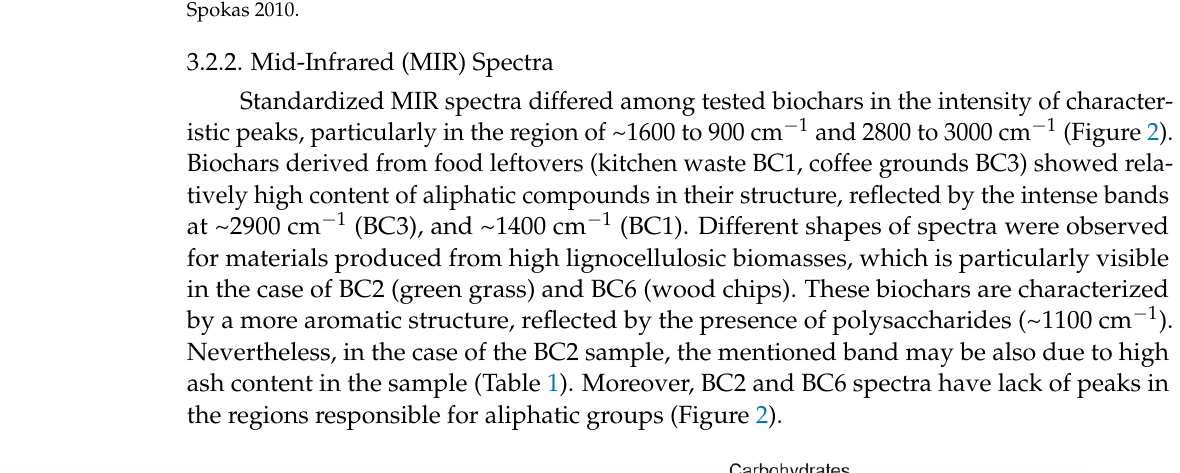
Figure 1. Van Krevelen’s diagram for examined biochars. The arrow indicates direction of changes in expected biochar’s stability.